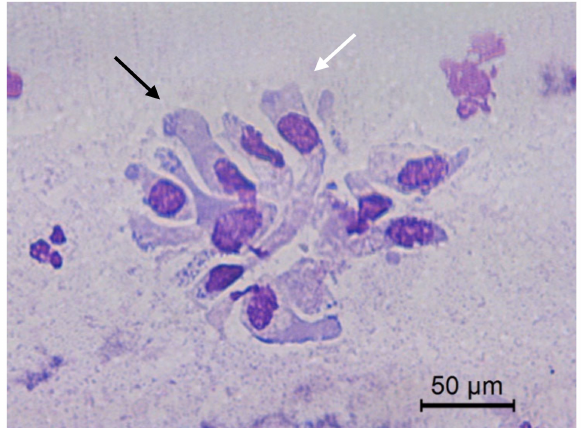
Figure 5. Jenny’s endometrial cytology collected by CB in estrus. Individualized endometrial epithelial cells in apposition, elongated cytoplasm, cilitated (black arrow) and non ciliated (white arrow). Granular background present. Modified Wright’s stain 400 ×